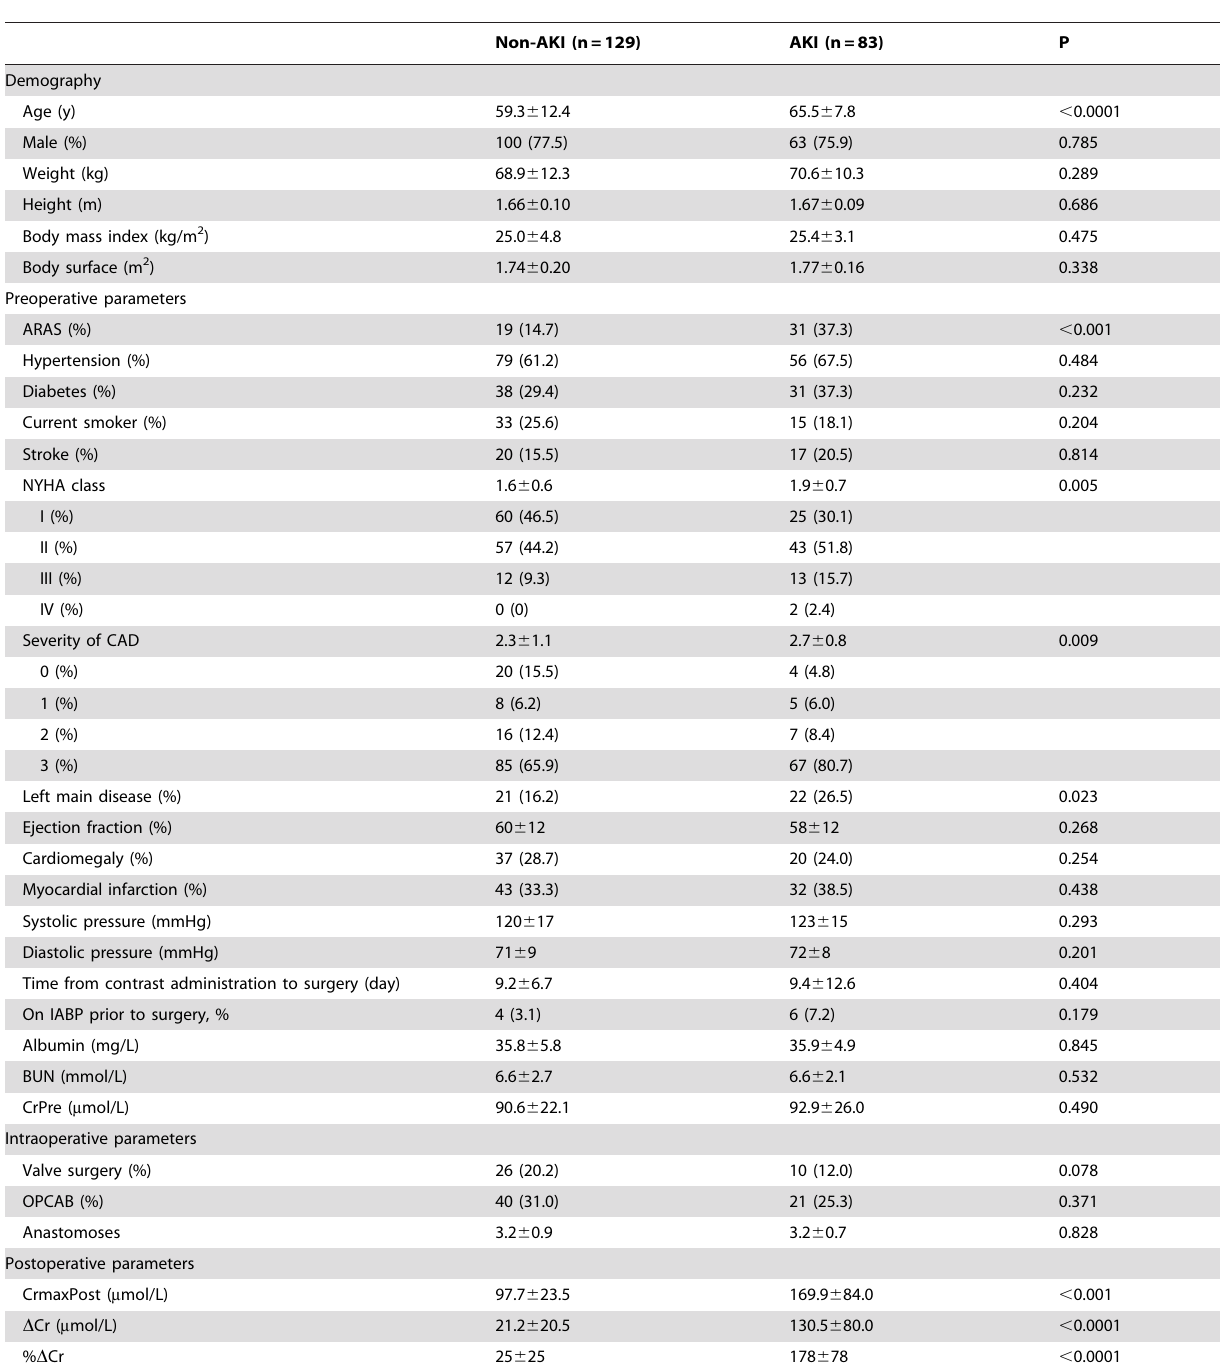
Table 1. Differences of baseline, intraoperative and postoperative variables between AKI and non-AKI patients.